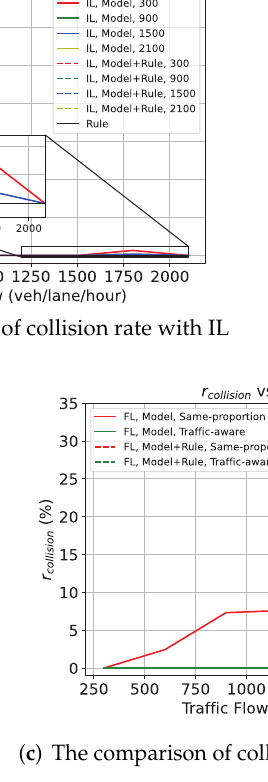
Figure 5. The comparison of collision rate r collision .